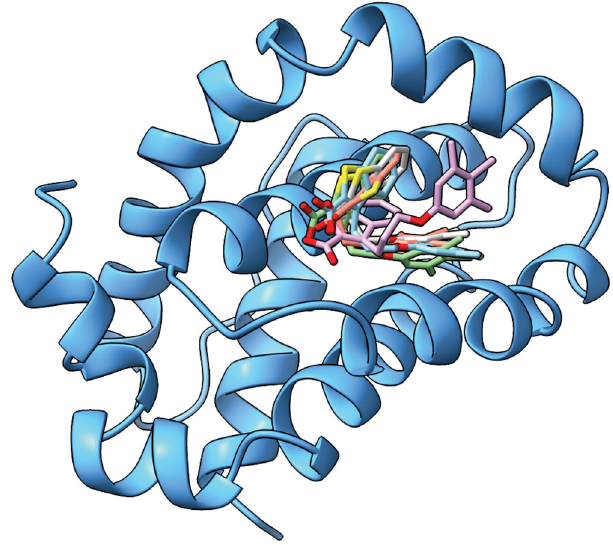
Fig. 5 Overlay of the starting con fi gurations of each replica of the ABFE calculations for ligand 60 in MCL-1. The re-arrangement (pink coloured ligand) of the merged ligand 60 in the MCL-1 binding site can clearly be